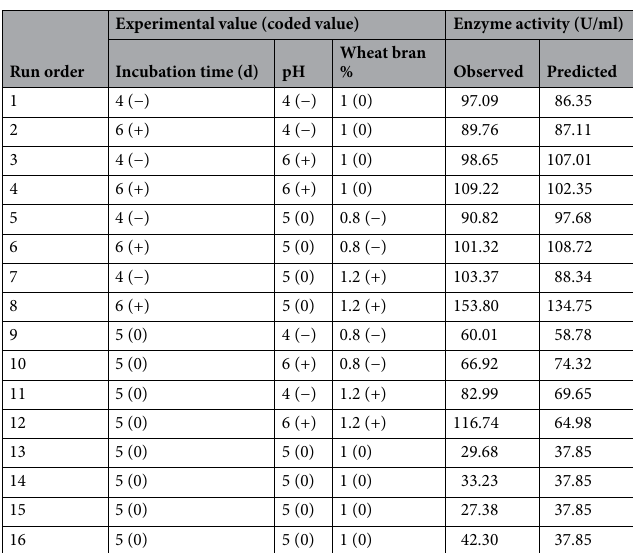
Table 4. Experimental design for the BBD model for three significant independent variables (Incubation time, pH, and wheat bran) tested and predicted and observed responses for xylanase